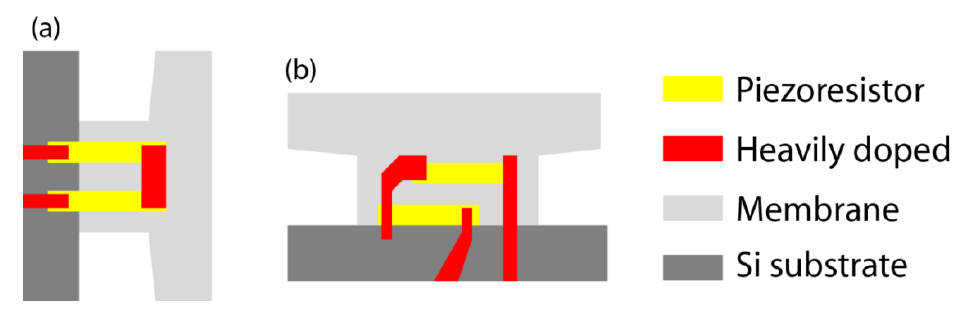
and ( b ) R in the 2G-MSS 1 2